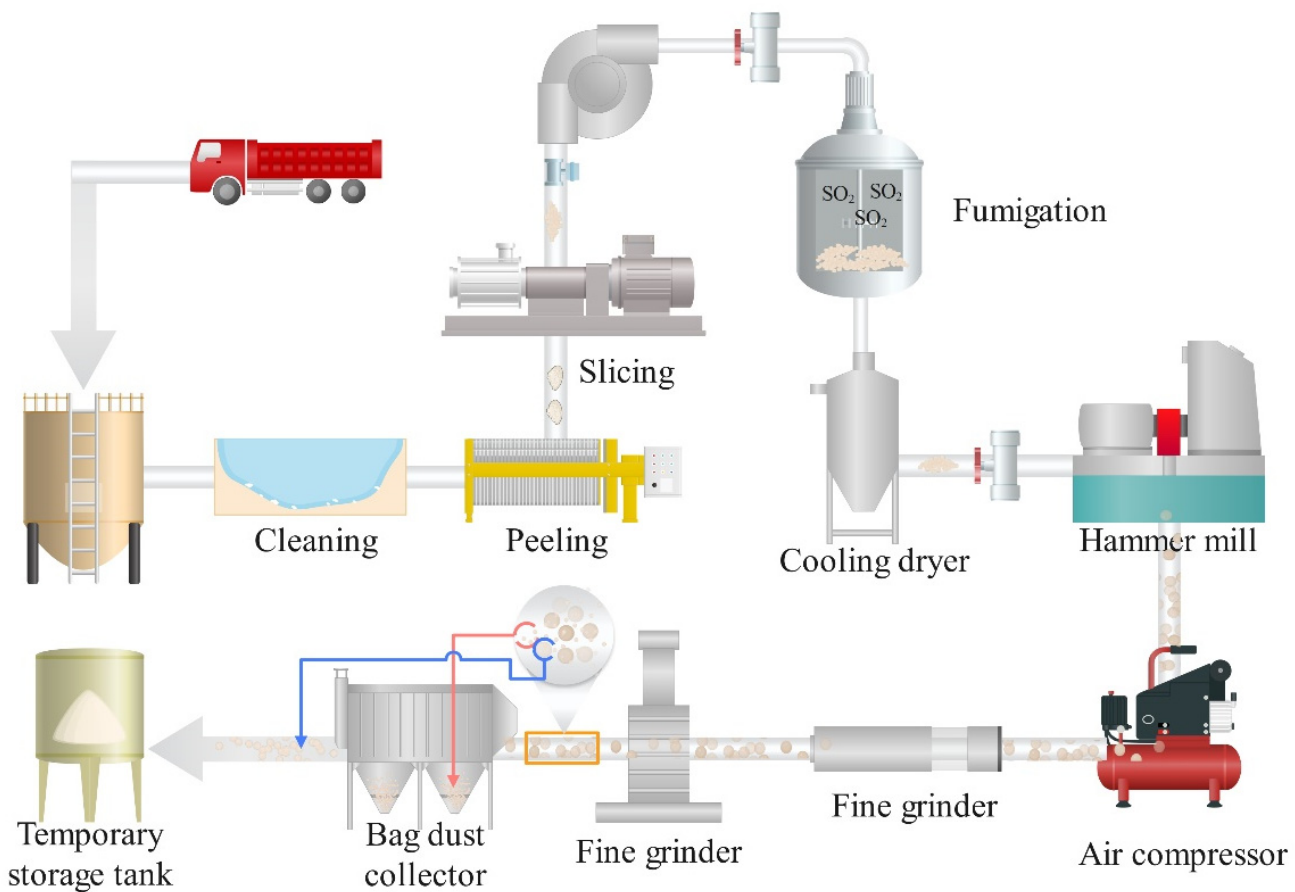
Figure 2. Flow chart of dry preparation of KGM in industry. After washing, peeling, and slicing, the konjac chips will be mixed with SO 2 and hot air in a special device, and the color will be determined by fumigation, then it will be put into the drying equipment immediately, and the konjac chips will be crushed to the powder by hammer grinder and fine grinder. Finally, under the action of grinding and sorting machine and bag dust collector, the finer flying powder such as starch and cellulose will be removed, and only KGM will be retained.